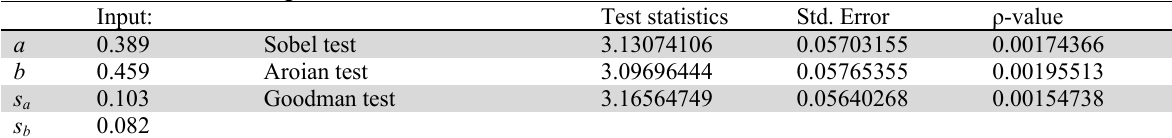
Sobel test results for marketing mix, E-WOM and re-visit